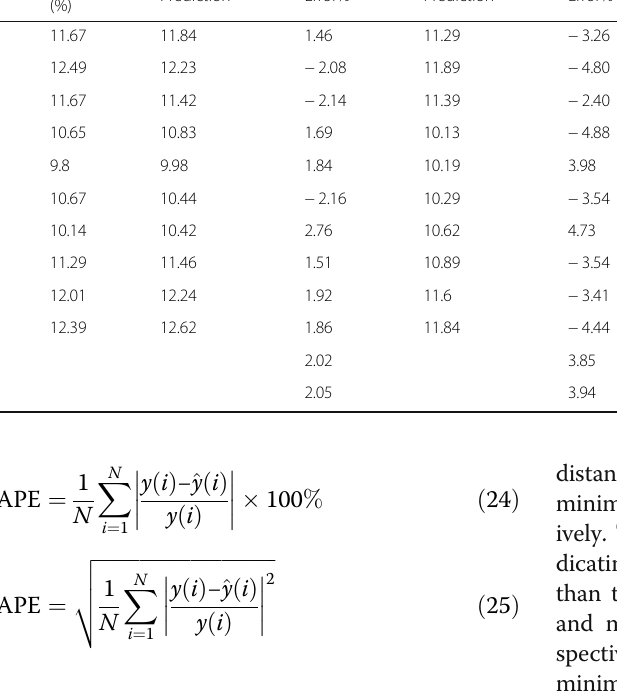
Table 1 Part of the forecasting values and relative errors of each model Real data